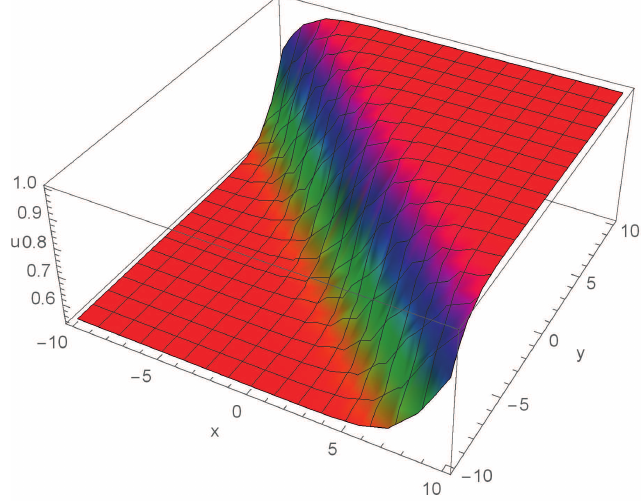
Fig. 5 The surface plot of the PIA solution u 4 ( x , y , t ) for ℜ = 100 and t = 0 . 1 when α = 0 . 95